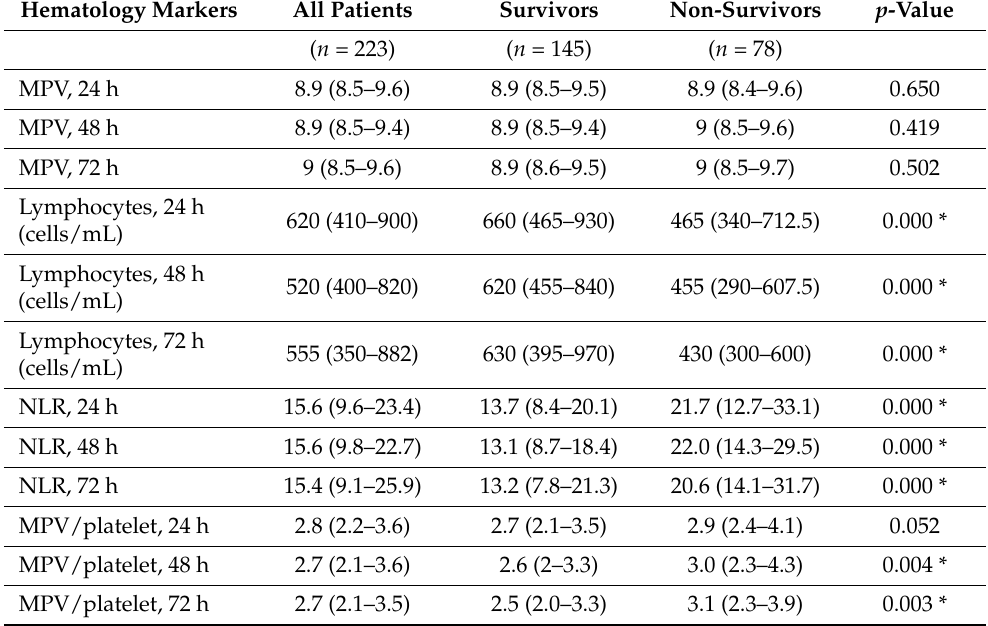
Table 3. Hematological markers in the overall population, as well as survivors and non-survivors in the intensive care unit. Data are expressed as medians (1st quartile (Q1)–3rd quartile (Q3)). * Significant differences between survivors and non-survivors based on Mann–Whitney U test. MPV: mean platelet volume; NLR: neutrophil/lymphocyte ratio.